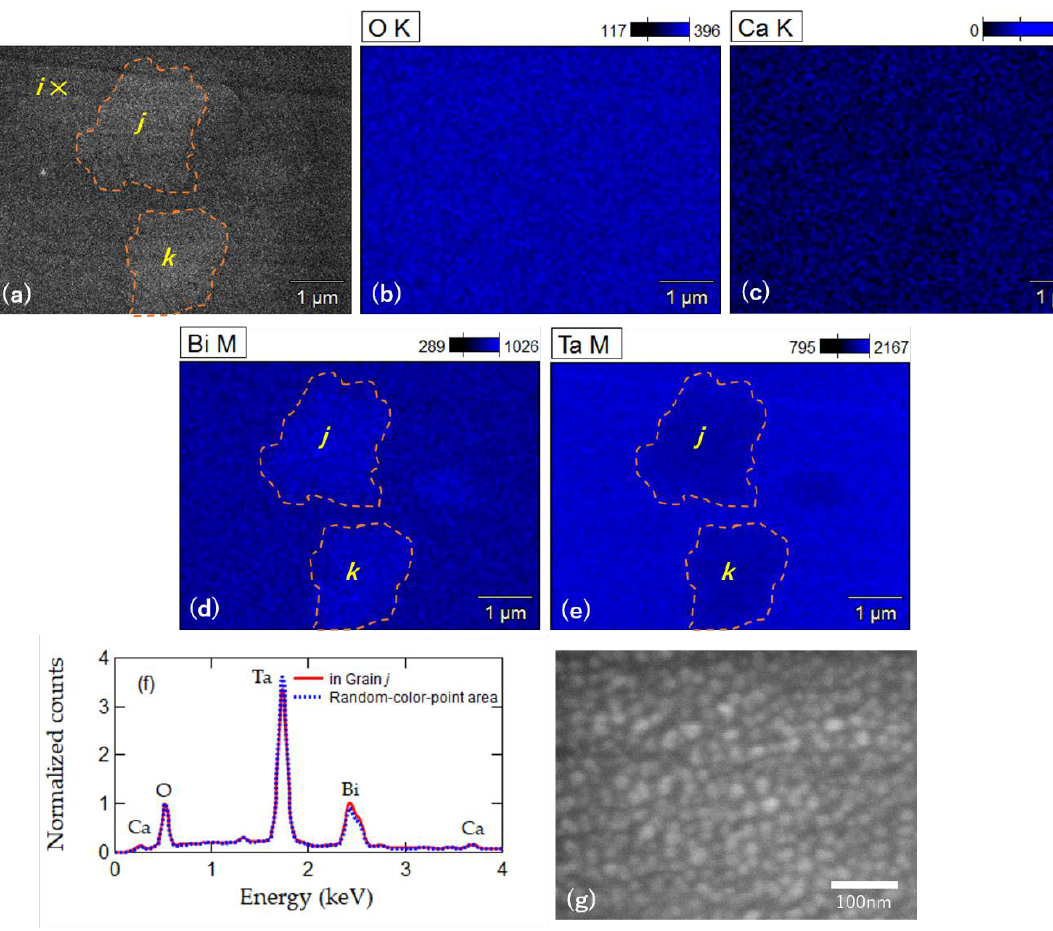
Figure 6. ( a ) Gray-colored energy dispersive X-ray spectroscopy (EDX) map of the integrated counts. The grains j and k are the same grains appearing in Figure 2e. The EDX element mapping of ( b ) O; ( c ) Ca; ( d ) Bi; and ( e ) Ta. Each color bar at the top right in ( b – e ) represents a scale of intensity counts of the element. The color for the zero intensity would be black; ( f ) EDX spectra both on the area j and on the multi-color-dot area, where the counts are normalized to the O peak; ( g ) SEM image at the spot i , shown in ( a